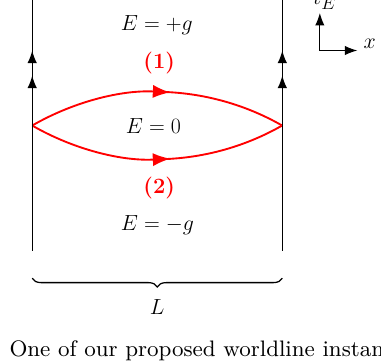
Figure 1. Some of the instantons in higher dimensional space proposed in the literature [1–3, 5, 10].